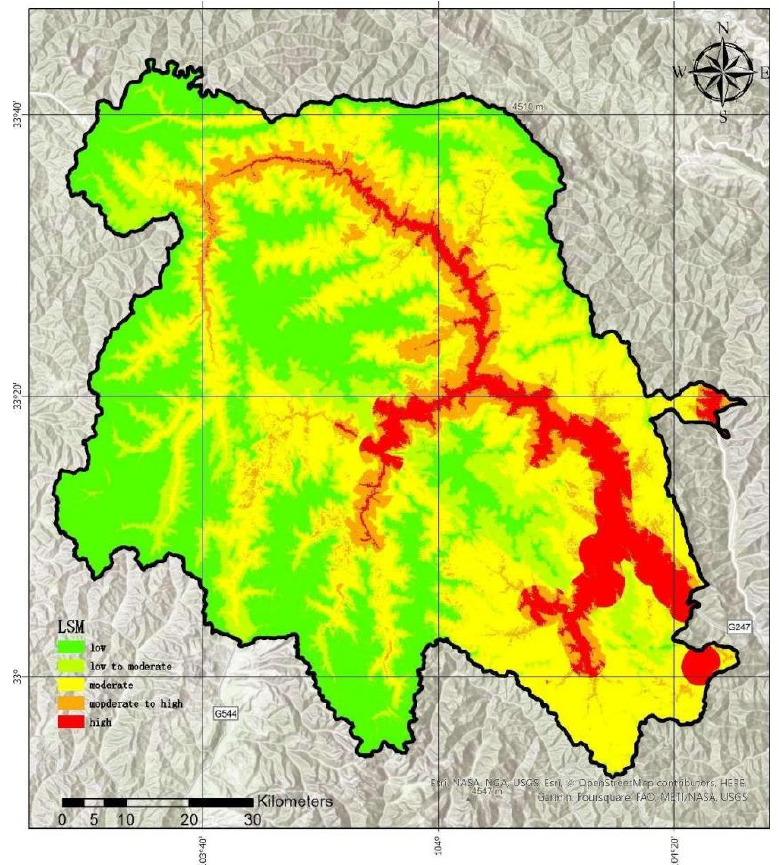
Figure 10. The preliminary LSM (post-earthquake) produced by the proposed method, including low susceptibility, low to moderate susceptibility, moderate susceptibility, moderate to high susceptibility and high susceptibility.